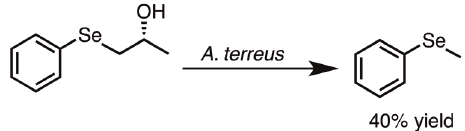
Figure 45 - Biomethylation reaction of (S)-1-(phenylseleno)-